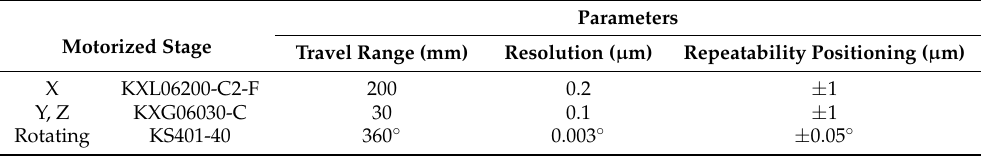
Table 2. Specification of motion stages.